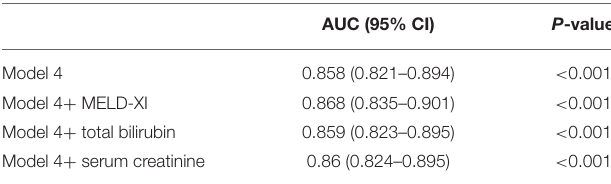
TABLE 3 | AUC of models predicting 60-day in-hospital all-cause